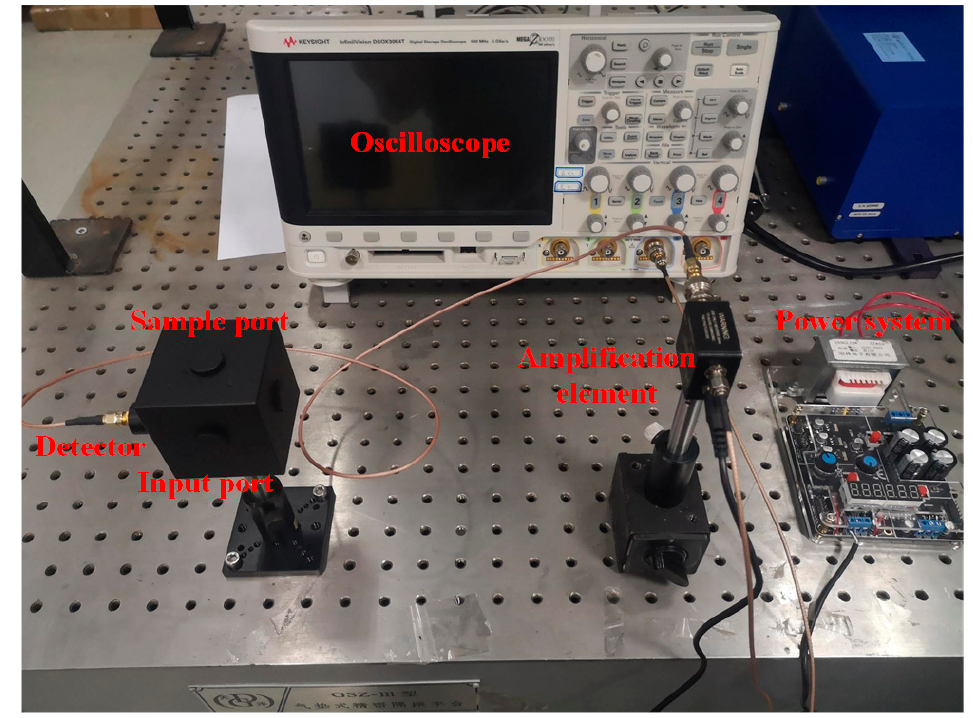
Figure 3. Measurement system.